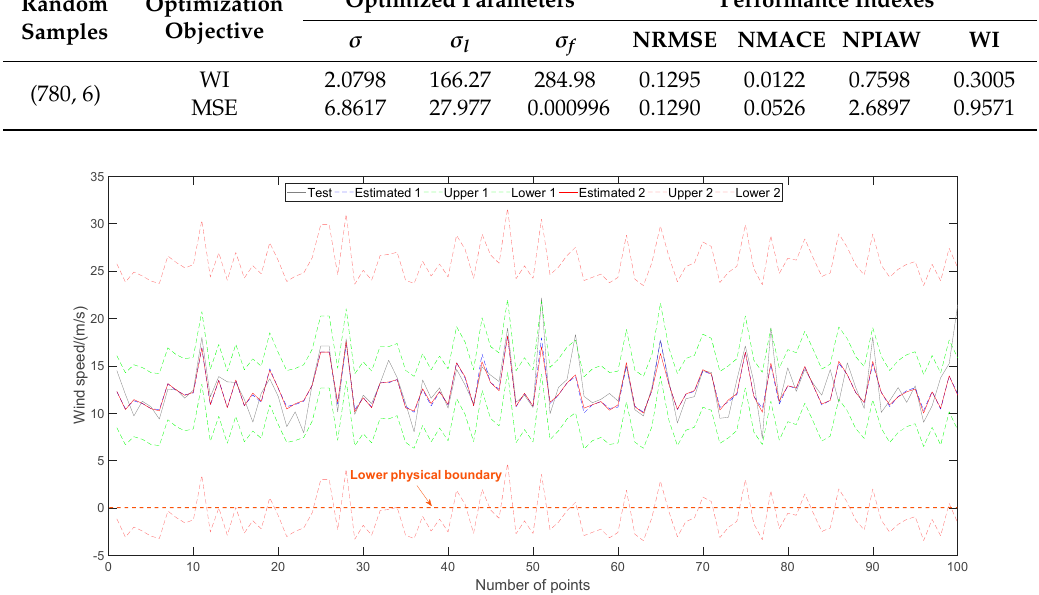
Figure 6. Comparison of wind speed prediction using different objectives.